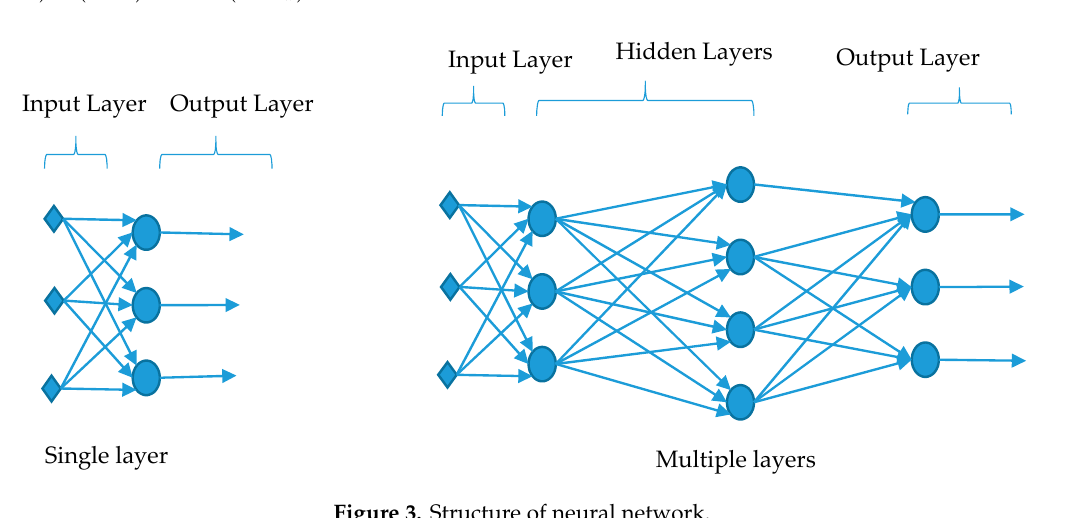
Figure 3. Structure of neural